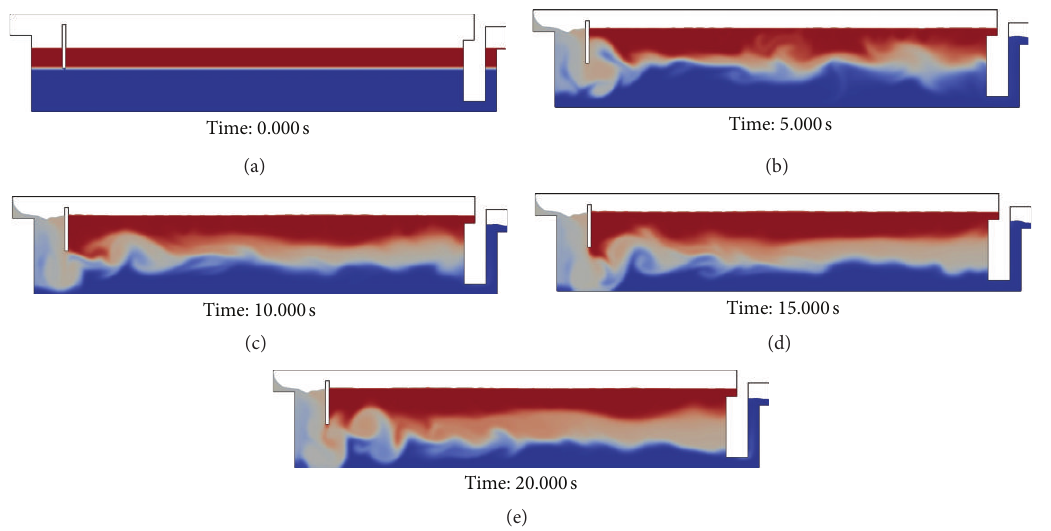
Figure 5: Time evolution of phase fraction field for a separating liquid-liquid dispersion in a horizontal